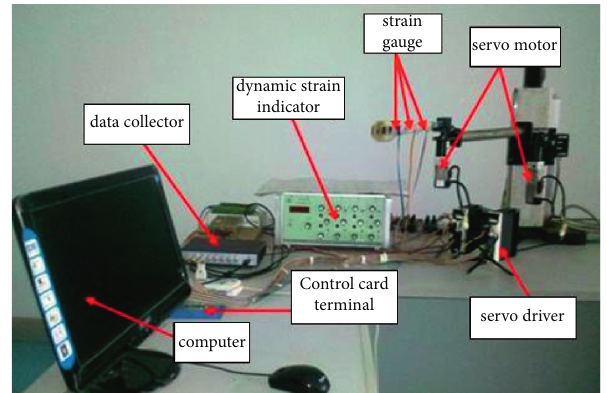
Figure 14: Experiment platform.